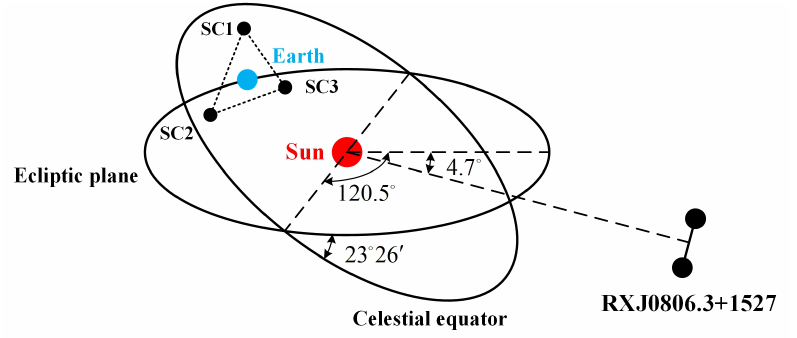
Figure 1. An illustration of the preliminary concept of the geocentric gravitational-wave observatory.